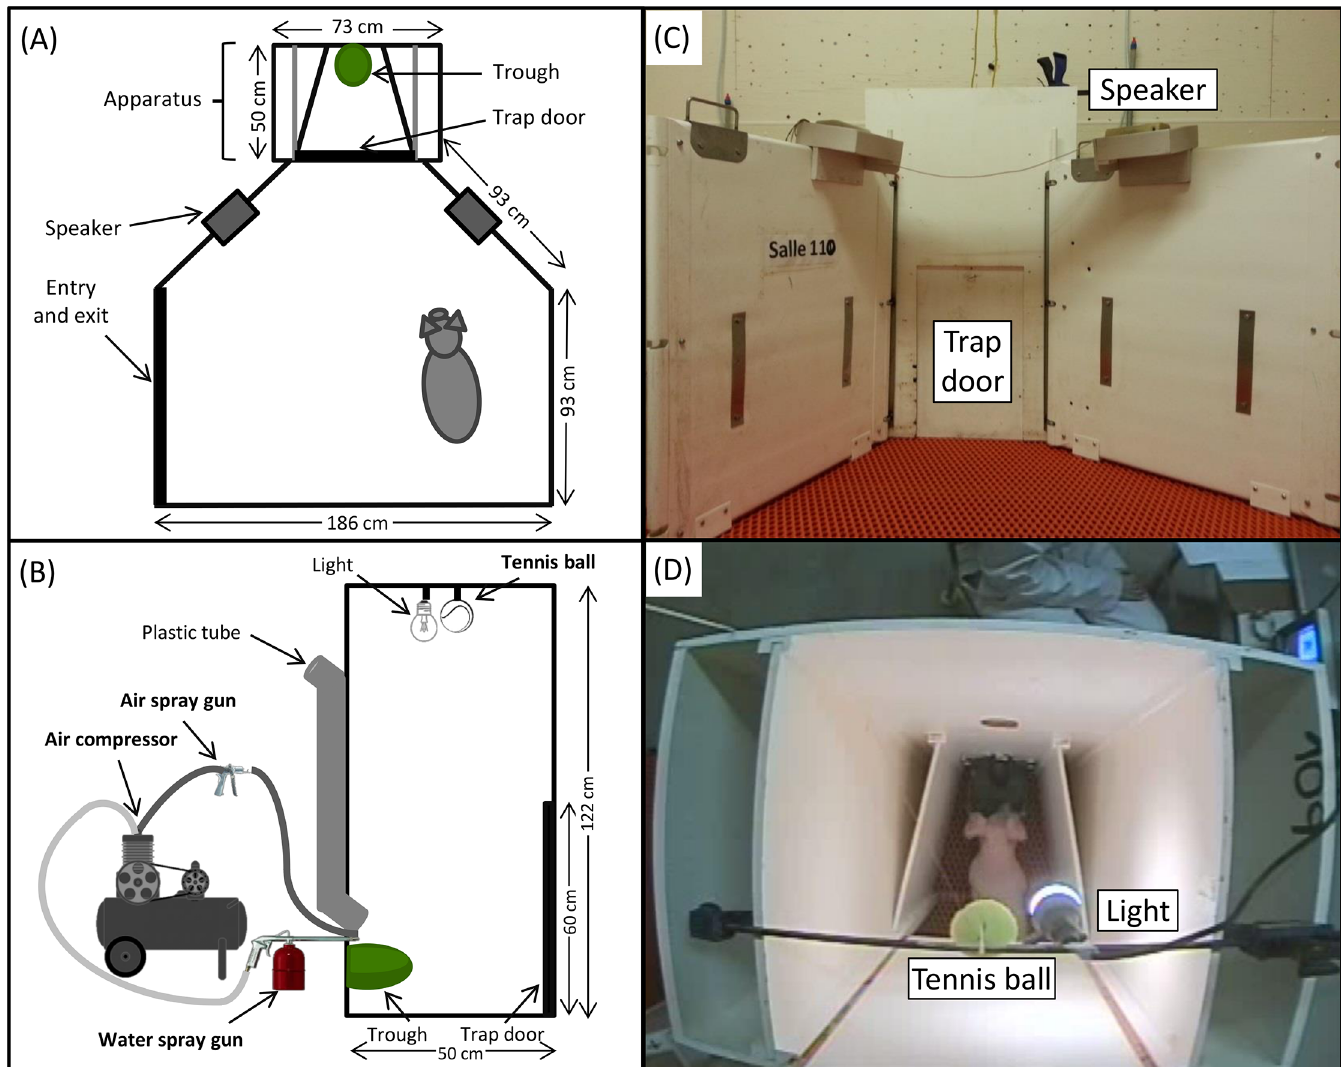
Fig 1. Overview of the testing arena and the apparatus. (A) Sketch of the testing arena viewed from the top, including the apparatus and the speakers; (B) Sketch of the apparatus viewed from the side, including the camera, the light, the plastic tube and the trough. In bold topography, a part of the material used for punishments, including the tennis ball relied on a fishing line, the air compressor relied on an air spray gun and a water spray gun; (C) Picture of the apparatus viewed from the front; (D) Picture of the apparatus viewed from the top with a piglet at the trough.